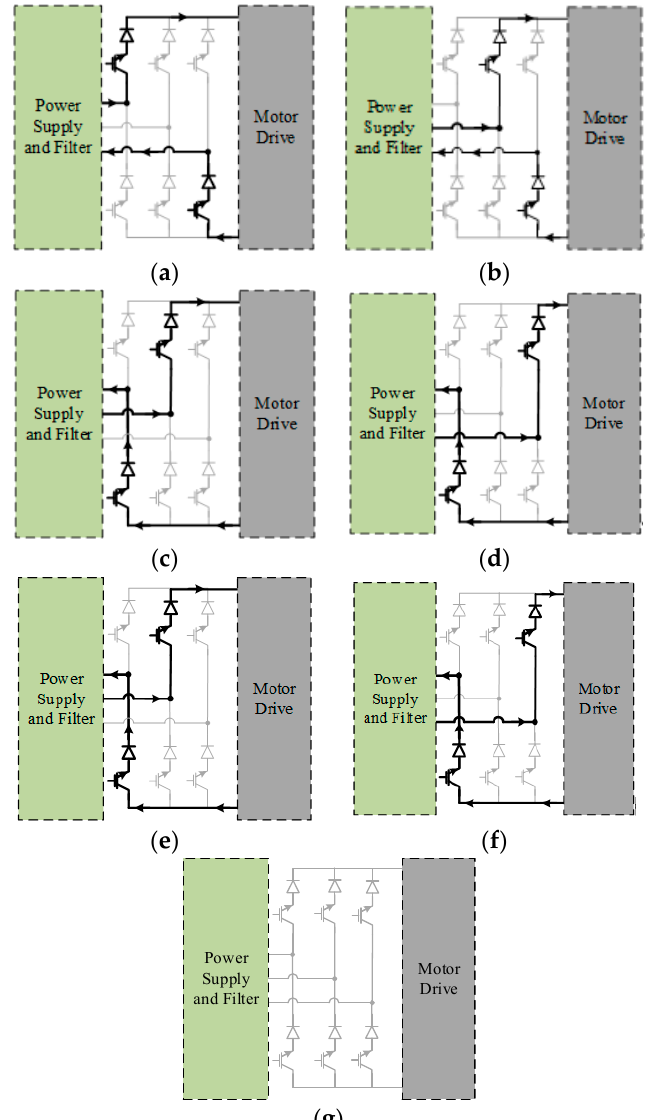
Figure 2. Modes of the on-board integrated battery charger: ( a ) mode 1; ( b ) mode 2; ( c ) mode 3; ( d ) mode 4; ( e ) mode 5; ( f ) mode 6; ( g ) mode 7.